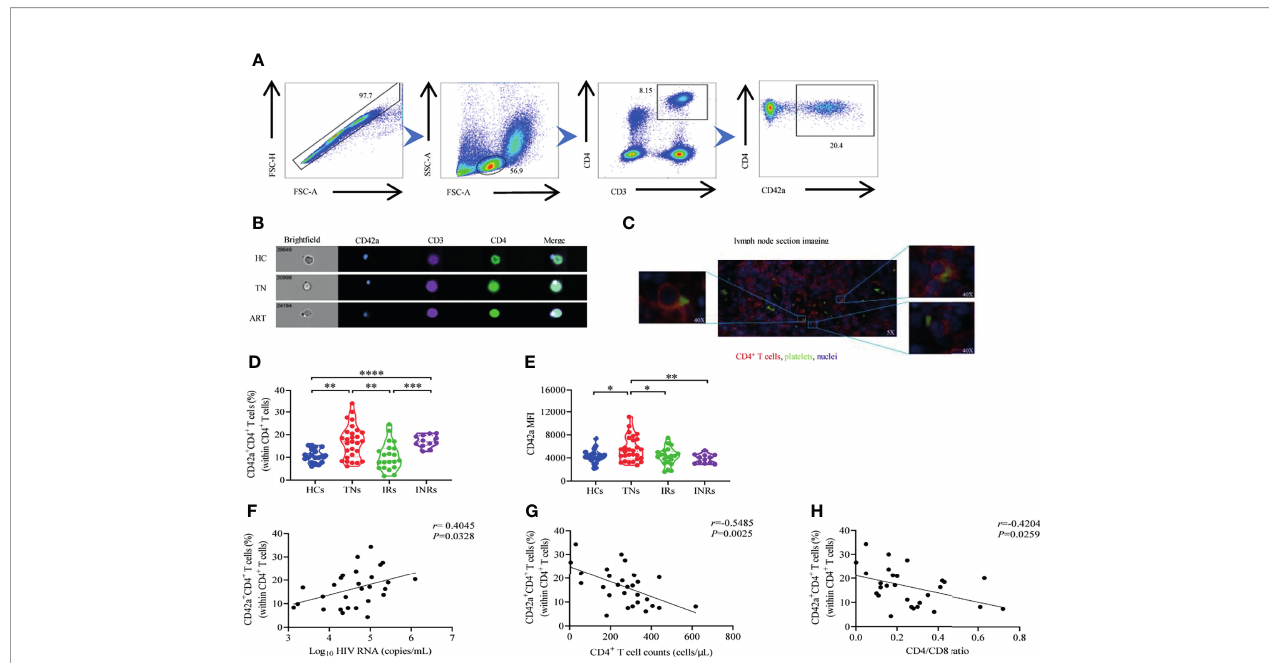
FIGURE 1 | Detection of platelet-CD4 + T cell aggregates in HCs, TNs, IRs, and INRs. (A) Representative gating strategy for the fl ow cytometry analysis of platelet- CD4 + T cell aggregates and platelet-free CD4 + T cells from a TN patient. CD42a + CD4 + T cells represent platelet-CD4 + T cell aggregates while CD42a - CD4 + T cells represent platelet-free CD4 + T cells. (B) Representative image of circulating platelet-CD4 + T cell aggregates that came separately from HC and HIV-1-infected patients with or without ART as obtained from imaging fl ow cytometry. Platelets are recognized by anti-CD42a FITC (blue) while CD4 + T cells are recognized by anti- human CD3 BV510 (purple) and anti-human CD4 BV421 (green). (C) Representative images of platelet-CD4 + T cell aggregates in lymph nodes from an HIV-1- infected patient without ART as visualized via immuno fl uorescence microscopy. (D) Comparison of platelet-CD4 + T cell aggregate frequencies in CD4 + T cells from HCs (n=19), TNs (n=28), IRs (n=21) and INRs (n=12). (E) Median fl uorescence intensity (MFI) values of CD42a were measured in all four groups. (F – H) Correlation between (F) HIV-1 viral load, (G) absolute CD4 + T cell counts, and (H) CD4/CD8 ratio with platelet-CD4 + T cell aggregate frequencies in TNs (n=28). * P < 0.05, ** P ≤ 0.01, *** P ≤ 0.001, **** P ≤